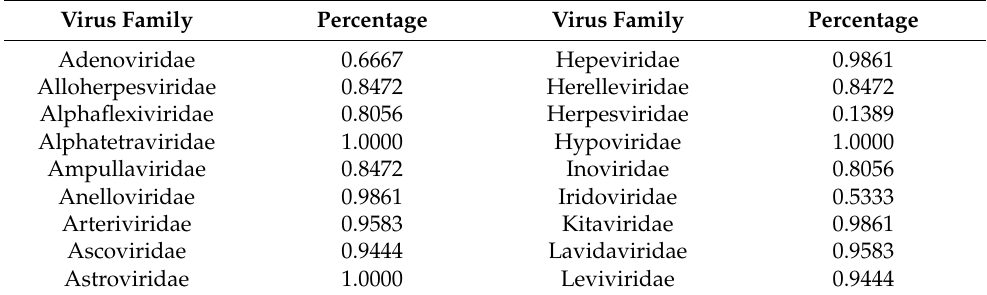
Table 5. Partial results of the convex hull intersection: ‘Percentage’ in this Table is the percentage of disjoint convex hull pairs of all convex hull pairs within one virus family of